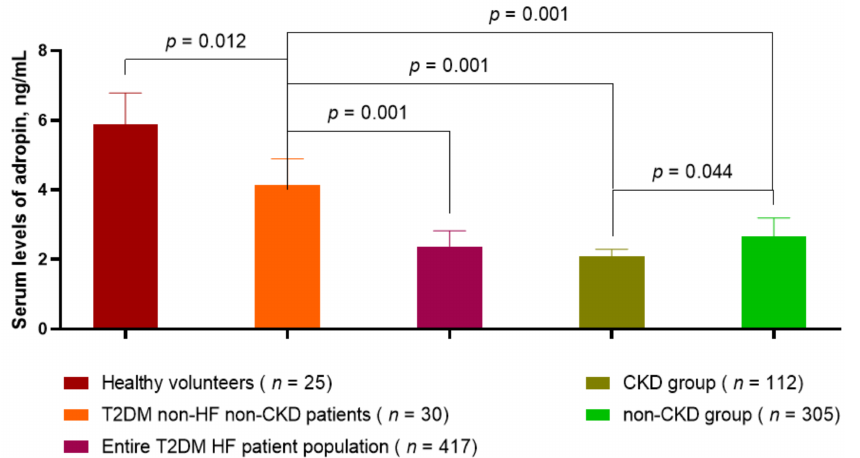
Figure 2. The levels of adropin (ng/mL) in the circulating blood of T2DM patients and healthy volun- teers. Abbreviations: CKD, chronic kidney disease; HF, heart failure; T2DM, type 2 diabetes